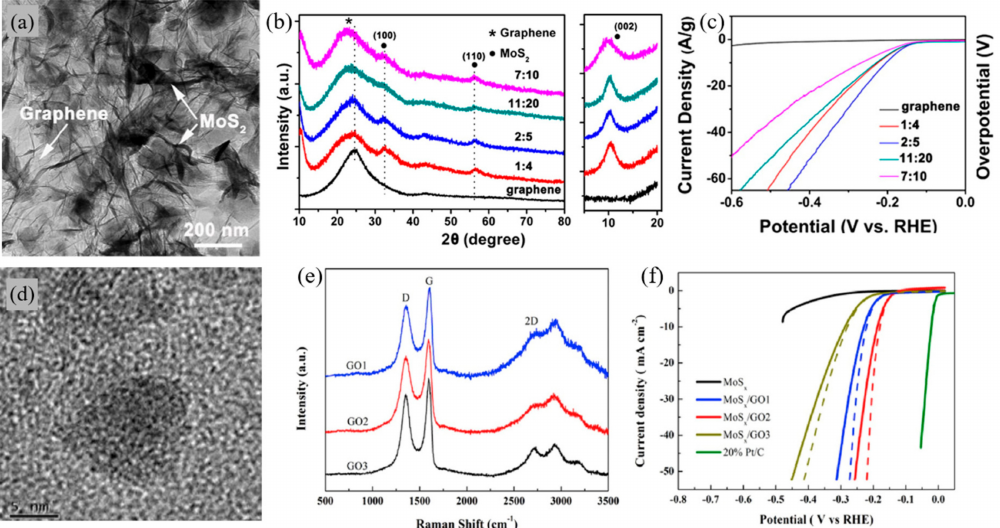
Figure 3. Graphene oxide (GO) applied in electrochemical cells for water splitting reactions. ( a ) Representative TEM image of the MoS 2 / Graphene, ( b ) XRD patterns of the MoS 2 / graphene hierarchical frameworks at di ff erent MoS 2 loadings and zoom-in of the low-angle region of the XRD profiles, ( c ) Polarization curves of MoS 2 / graphene 3D framework at di ff erent MoS 2 loadings. The currents were normalized to the total mass of the catalysts [46]. ( d ) HR-TEM image of the MoS x / GO nanocomposite, ( e ) Raman spectra of di ff erent GO, ( f ) Linear sweep voltammogram (LSV) curves in 0.5M H 2 SO 4 for di ff erent MoS x / GO electrocatalysts